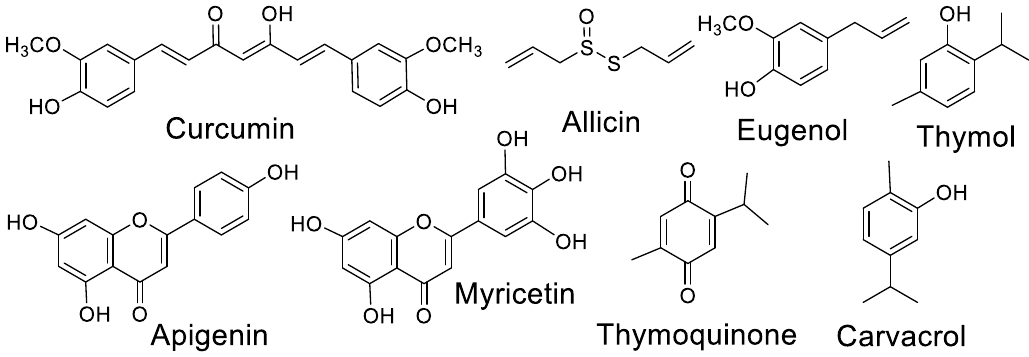
Figure 3. Chemical structures of relevant antiviral natural products in the context of COVID-19.